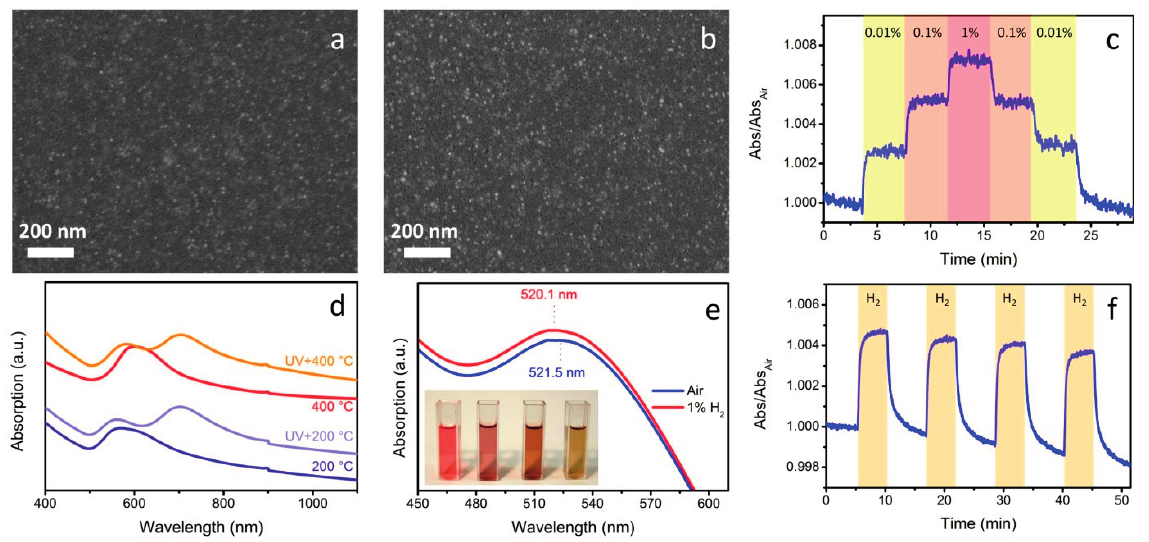
Figure 3. ( a ) SEM image of a TiO 2 -Au film annealed at 100 °C; ( b ) SEM image of a TiO 2 -Au film annealed at 500 °C; ( c ) Time resolved tests for a TiO 2 -Au film exposed to different concentrations of H 2 (in volume %) at 300 °C ( λ = 595 nm); ( d ) Optical absorption spectra of TiO 2 -Au NRs films synthesized from layered titanates showing the effect of UV treatment in avoiding the spheroidization of Au NRs; ( e ) Optical absorption spectra of TiO 2 films containing Au-Pt core-shell NPs exposed to 1% hydrogen at room temperature. The inset shows Au-Pt colloidal solutions; ( f ) Time resolved tests for a TiO 2 -Au-Pt film exposed to 1% hydrogen at room temperature ( λ = 500